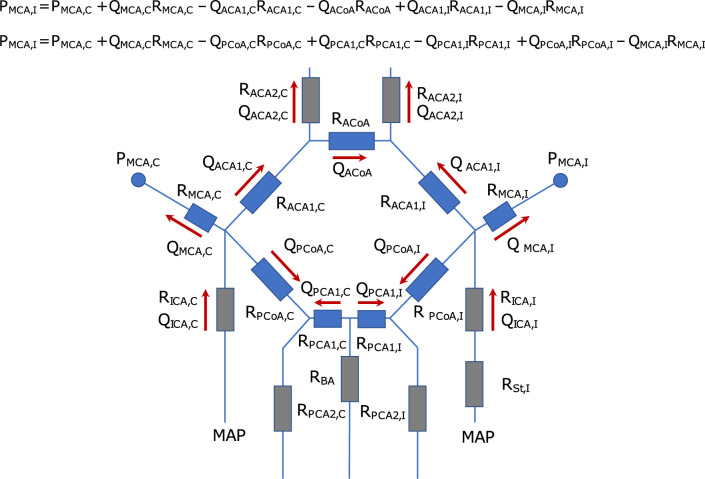
Circuit analogy of the circle of Willis.The figure illustrates a schematic of the CW, denoting the ipsi (I)- and contralateral (C) side of the ICA stenosis (St). It is modelled as an electrical circuit, where the change in pressure across each artery is related to the flow (Q) and the vascular resistance (R) of the artery. The arrows indicate the normal flow direction in each artery, and the circles indicate the two pressure sites for the ipsi- and contralateral MCA pressure (PMCA). The two equations for PMCA,I describe how the pressure changes, starting at PMCA,C, across the anterior collateral pathway versus the posterior collateral pathway. They show that the pressure laterality between the ipsi- and contralateral MCA must be the same for both pathways. Note that the MCA resistance only refers to the arterial segment from the bifurcation to the location of the pressure measurement.